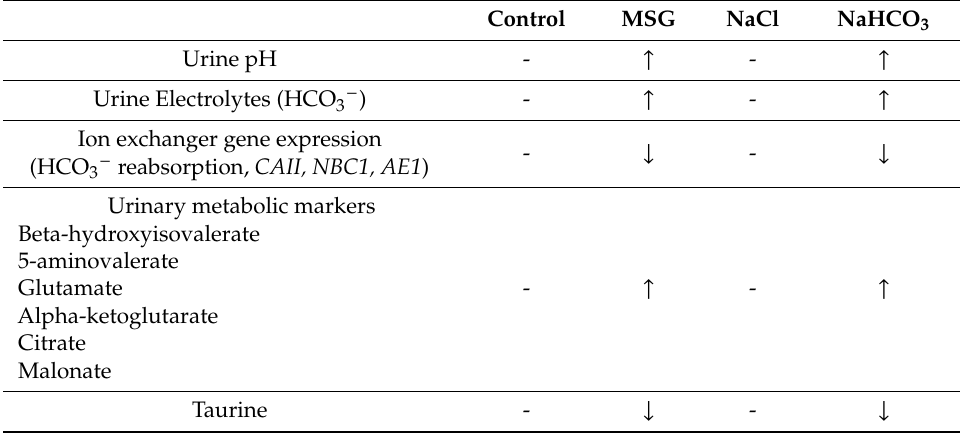
Table 3. The similar e ff ects of MSG and NaHCO 3 supplementation on urine pH, urine electrolytes, ion exchanger gene expression and urinary metabolic